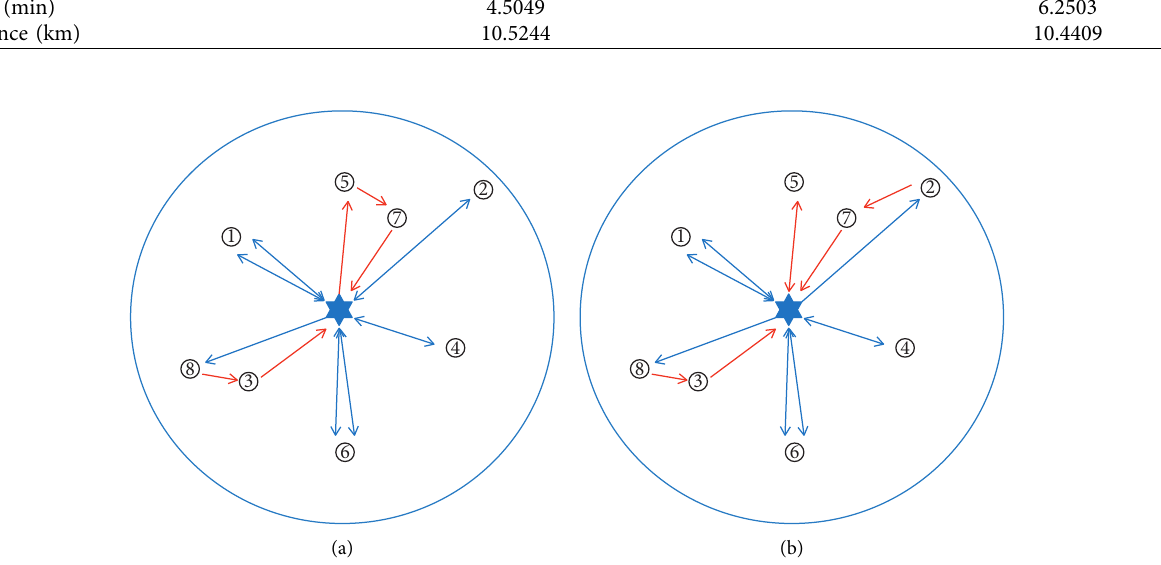
Figure 6: The effect of two algorithms: (a) local optimal algorithm and (b) global optimal